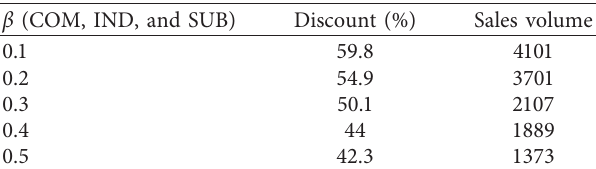
Table 7: Impact of the relative product reservation price